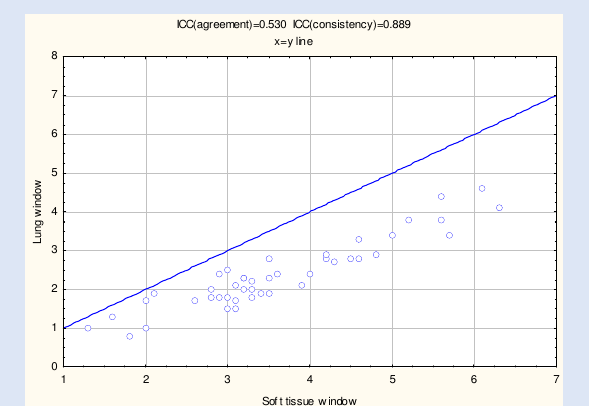
Graph 7. Comparison between measurements in soft tissue and lung windows in the bronchus intermedius. Graph 8. Comparison between measurements in soft tissue and lung windows in the left main bronchus 